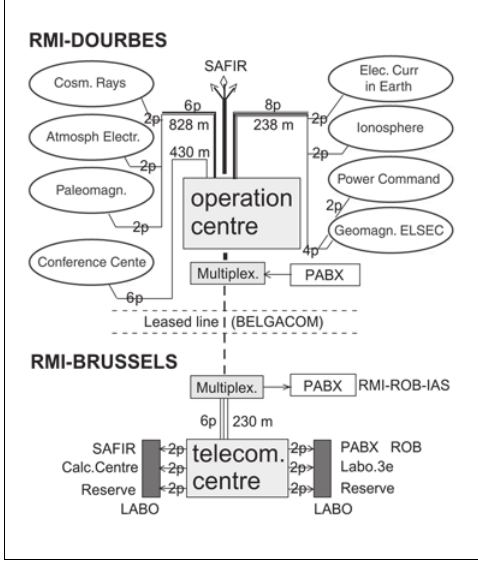
Fig. 1. The measurement and communication network of the Royal Meteorological Institute of Belgium. SAFIR – Thunderstorm alert system using radio interferometry. A 2p connection consists of two cables with two optic fibres in each